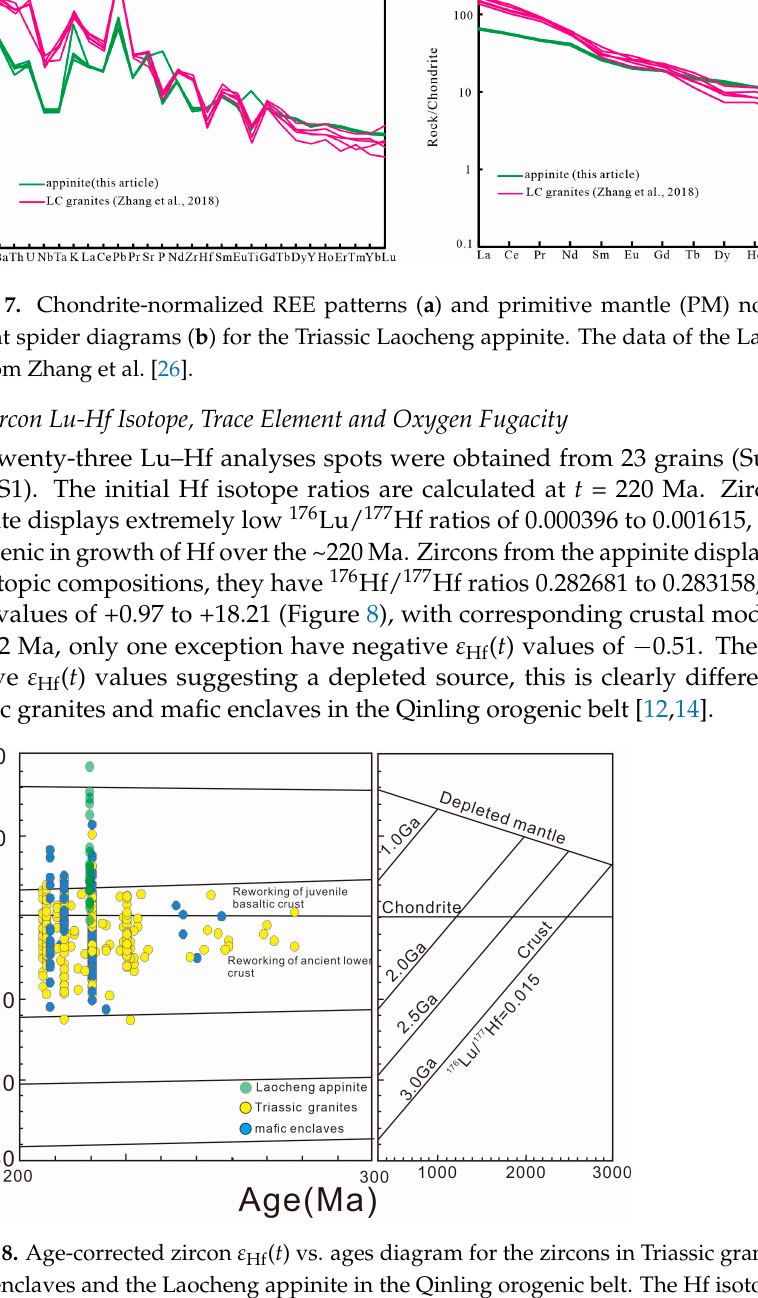
Figure 7. Chondrite-normalized REE patterns ( a ) and primitive mantle (PM) normalized trace ele- ment spider diagrams ( b ) for the Triassic Laocheng appinite. The data of the Laocheng granite was from Zhang et al. [26].